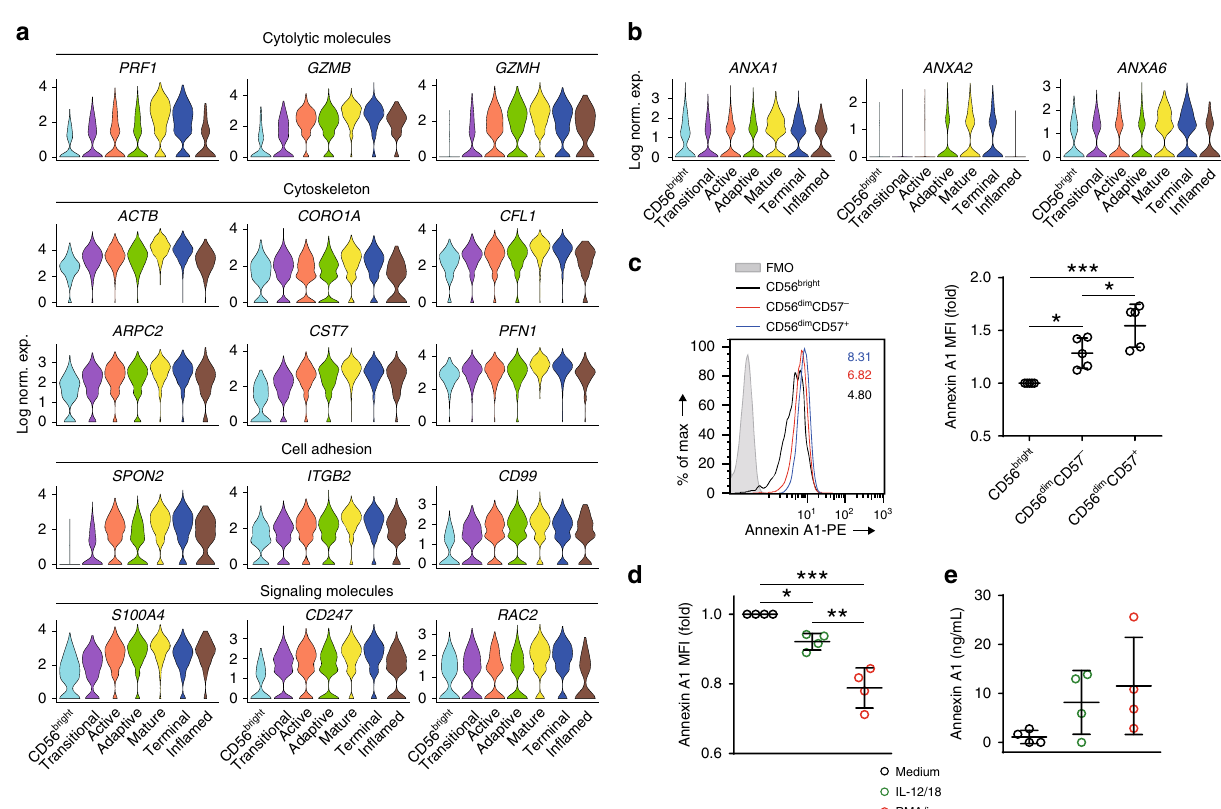
Fig. 6 Transcriptional signature of functionally mature NK cells. a Representative genes associated with functionally mature NK cells were grouped in four different categories and plotted via violin plots of the BM sample. The y -axis represents log-normalized expression value. b The expression of ANXA1 , ANXA2 , and ANXA6 in each cluster of the blood sample was shown as violin plots. The y -axis represents log-normalized expression value. c The intracellular protein level of Annexin A1 in different NK cell subsets from blood at steady state was assessed by fl ow cytometry. The representative histogram was shown on the left. FMO stands for fl uorescence minus one. The mean fl uorescence intensity (MFI) of Annexin A1 in each NK subsets was normalized to CD56 bright NK subset and shown on the right. n = 5 from three independent experiments. Error bars were shown as standard deviation.